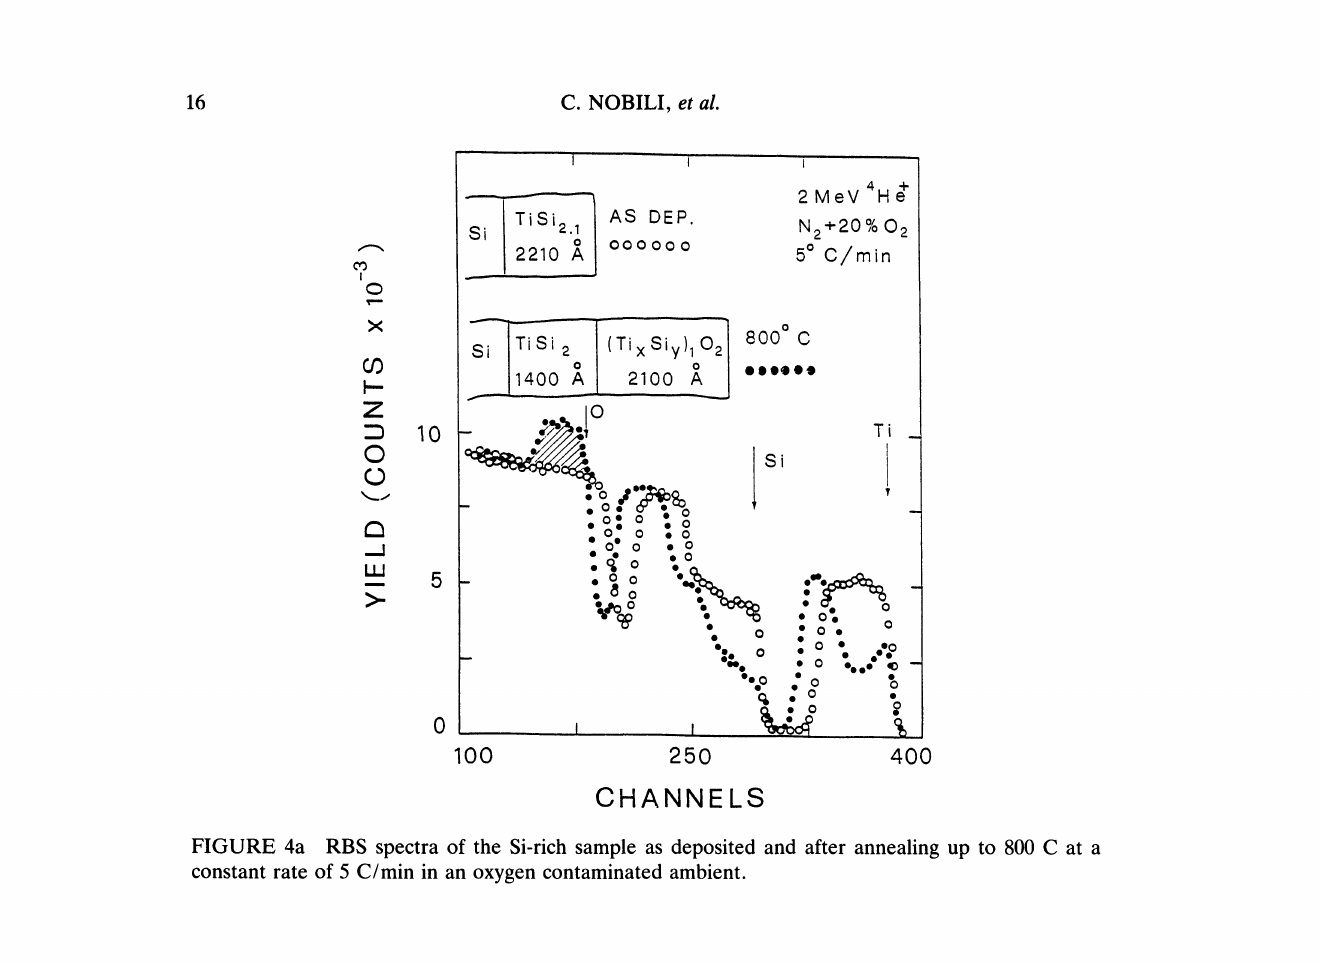
FIGURE 4a RBS spectra of the Si-rich sample as deposited and after annealing up to 800 C at a constant rate of 5 C/min in an oxygen contaminated